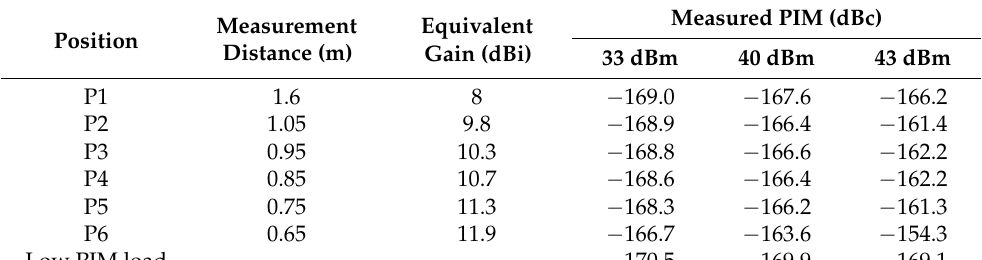
Table 2. Measured results of chamber A at 1730 MHz.